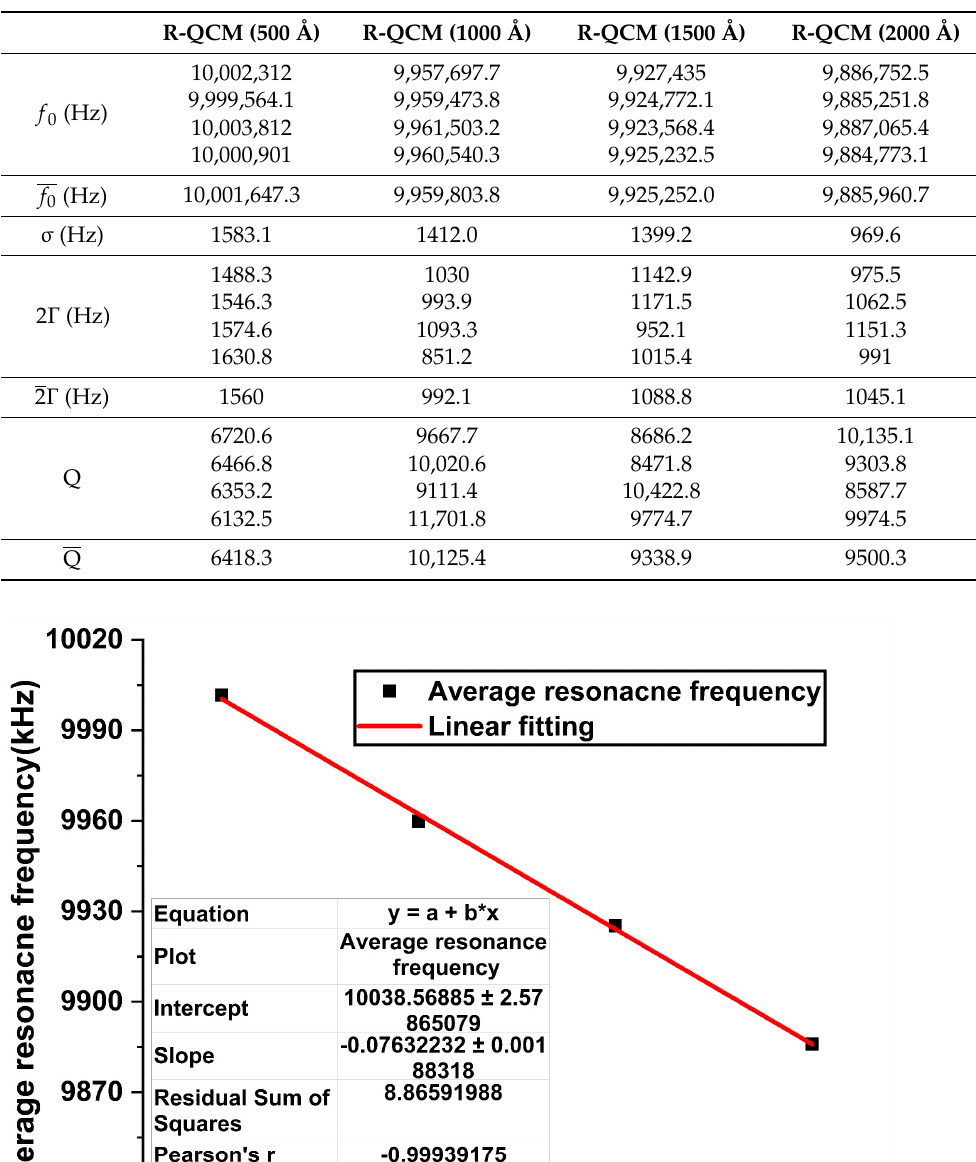
Table 1. The resonance frequencies and Q-factors of R-QCMs.